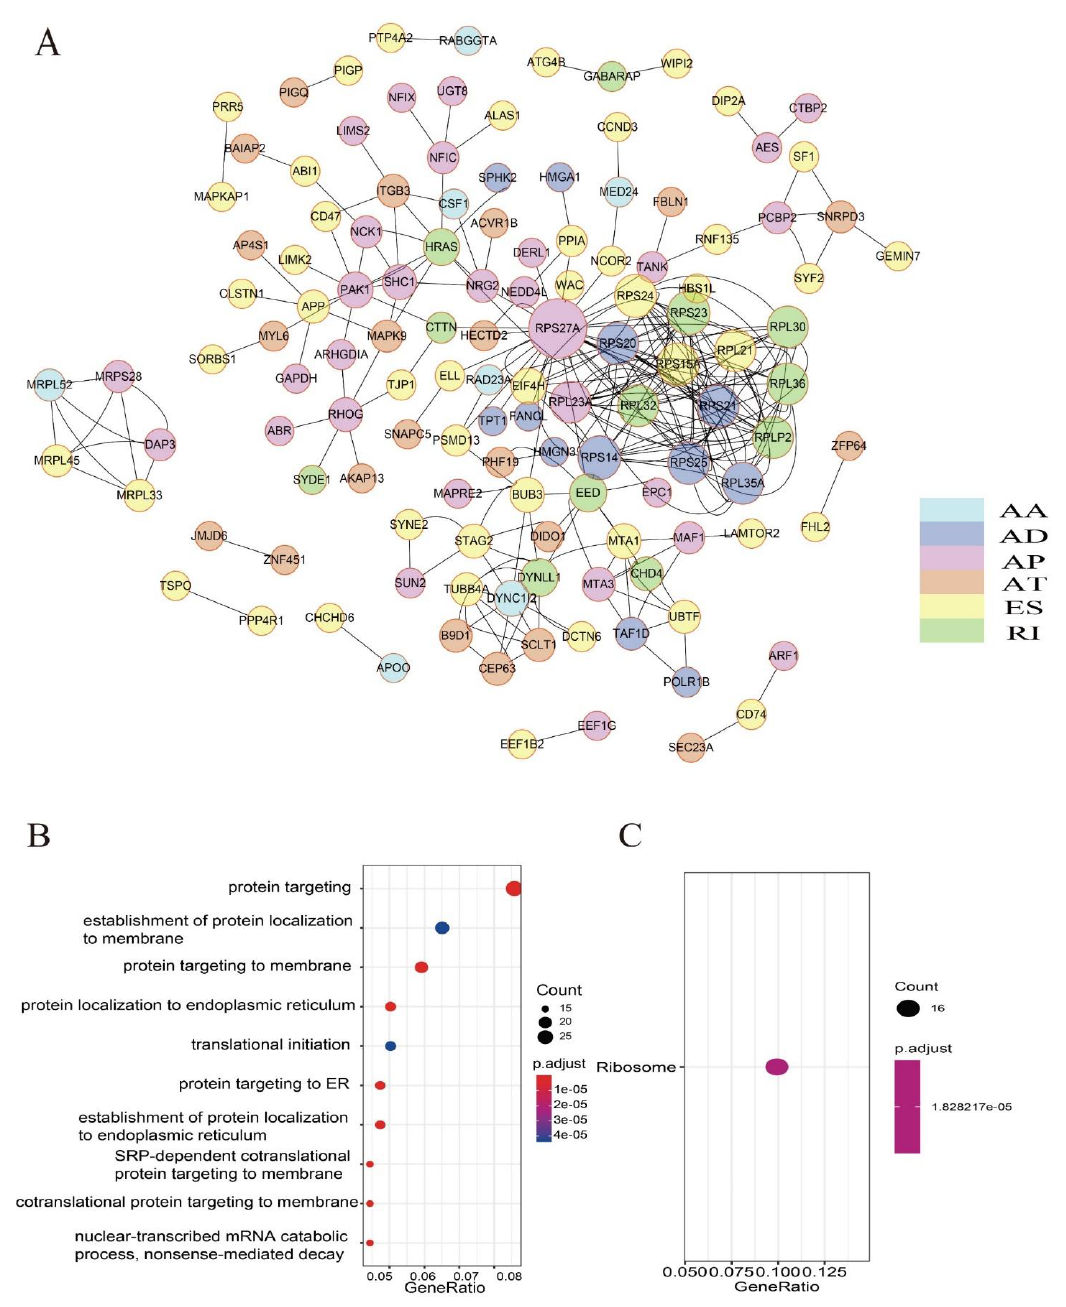
Figure 3. Interaction network of survival-related alternative splicing (AS) events. ( A ) Protein–protein interaction network of genes with survival-related AS events in UM. ( B ) Gene ontology (GO) analysis of genes with survival-related AS events. The x-axis stands for gene ration in the background gene, and the y-axis stands for the term of pathway. ( C ) KEGG pathway analysis of genes with survival-related AS events. The x-axis stands for gene ratio in the background gene, and the y-axis stands for the term of pathway.